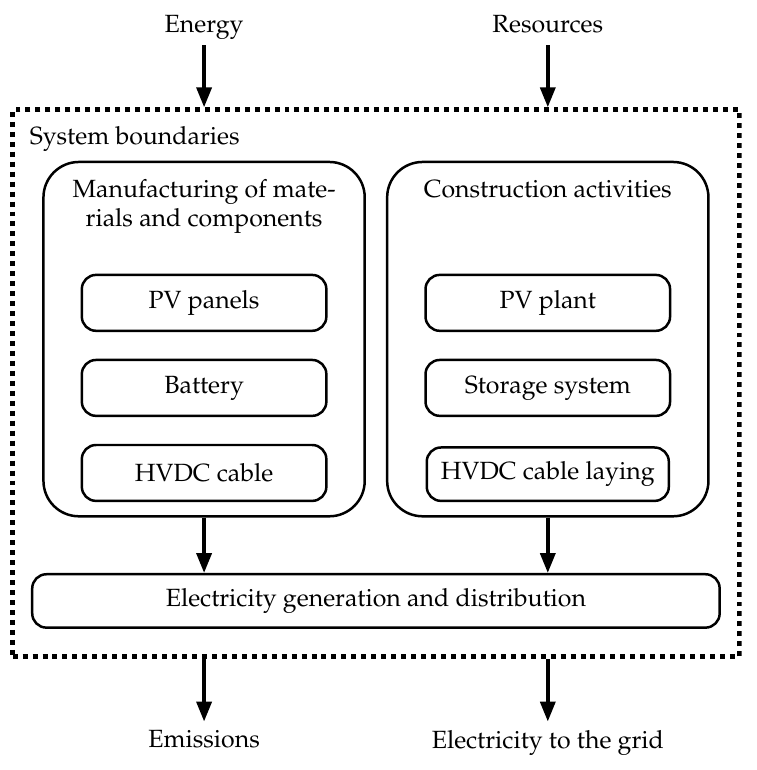
Figure 2. System